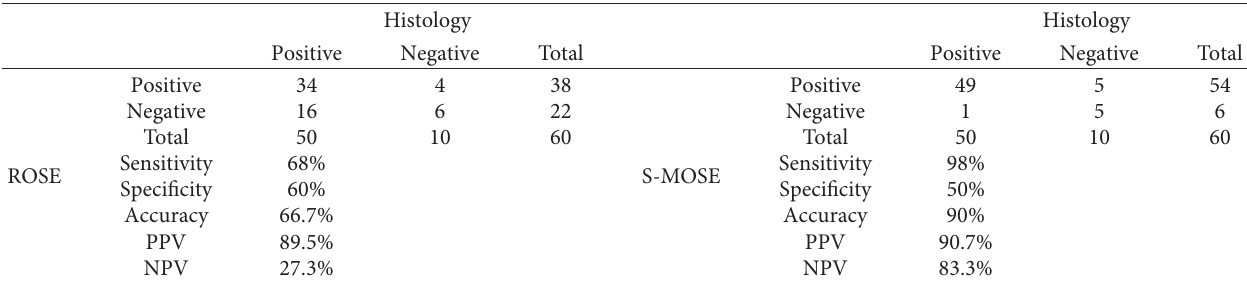
Table 3: ROSE and S-MOSE in comparison with